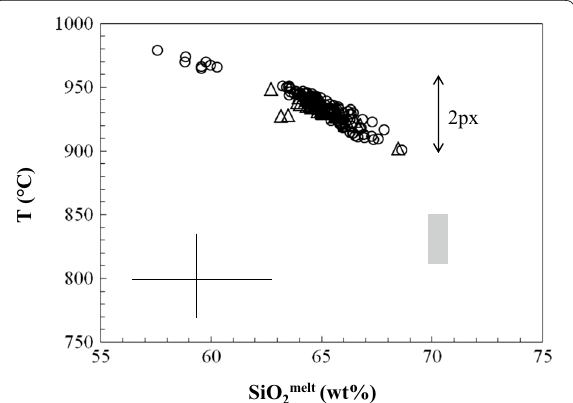
Fig. 4 Temperature conditions and SiO 2 contents of hydrous melt in equilibrium with amphibole phenocrysts, as estimated using the methods of Putirka (2016). Diamonds and circles indicate amphibole phenocrysts in samples 4I-1w and 4I-1p, respectively. Error bars indicate 1σ errors for estimations of temperature ( 3 wt%). Gray area shows the T– SiO melt 2 conditions and SiO melt 2 ( ± of the groundmass melt of the 4I-1 magma; the temperature is based on Fe–Ti oxide thermometry (from Kaneko et al. 2007). The double-headed arrow indicates the range estimated using two-pyroxene thermometry (from Kaneko et al.